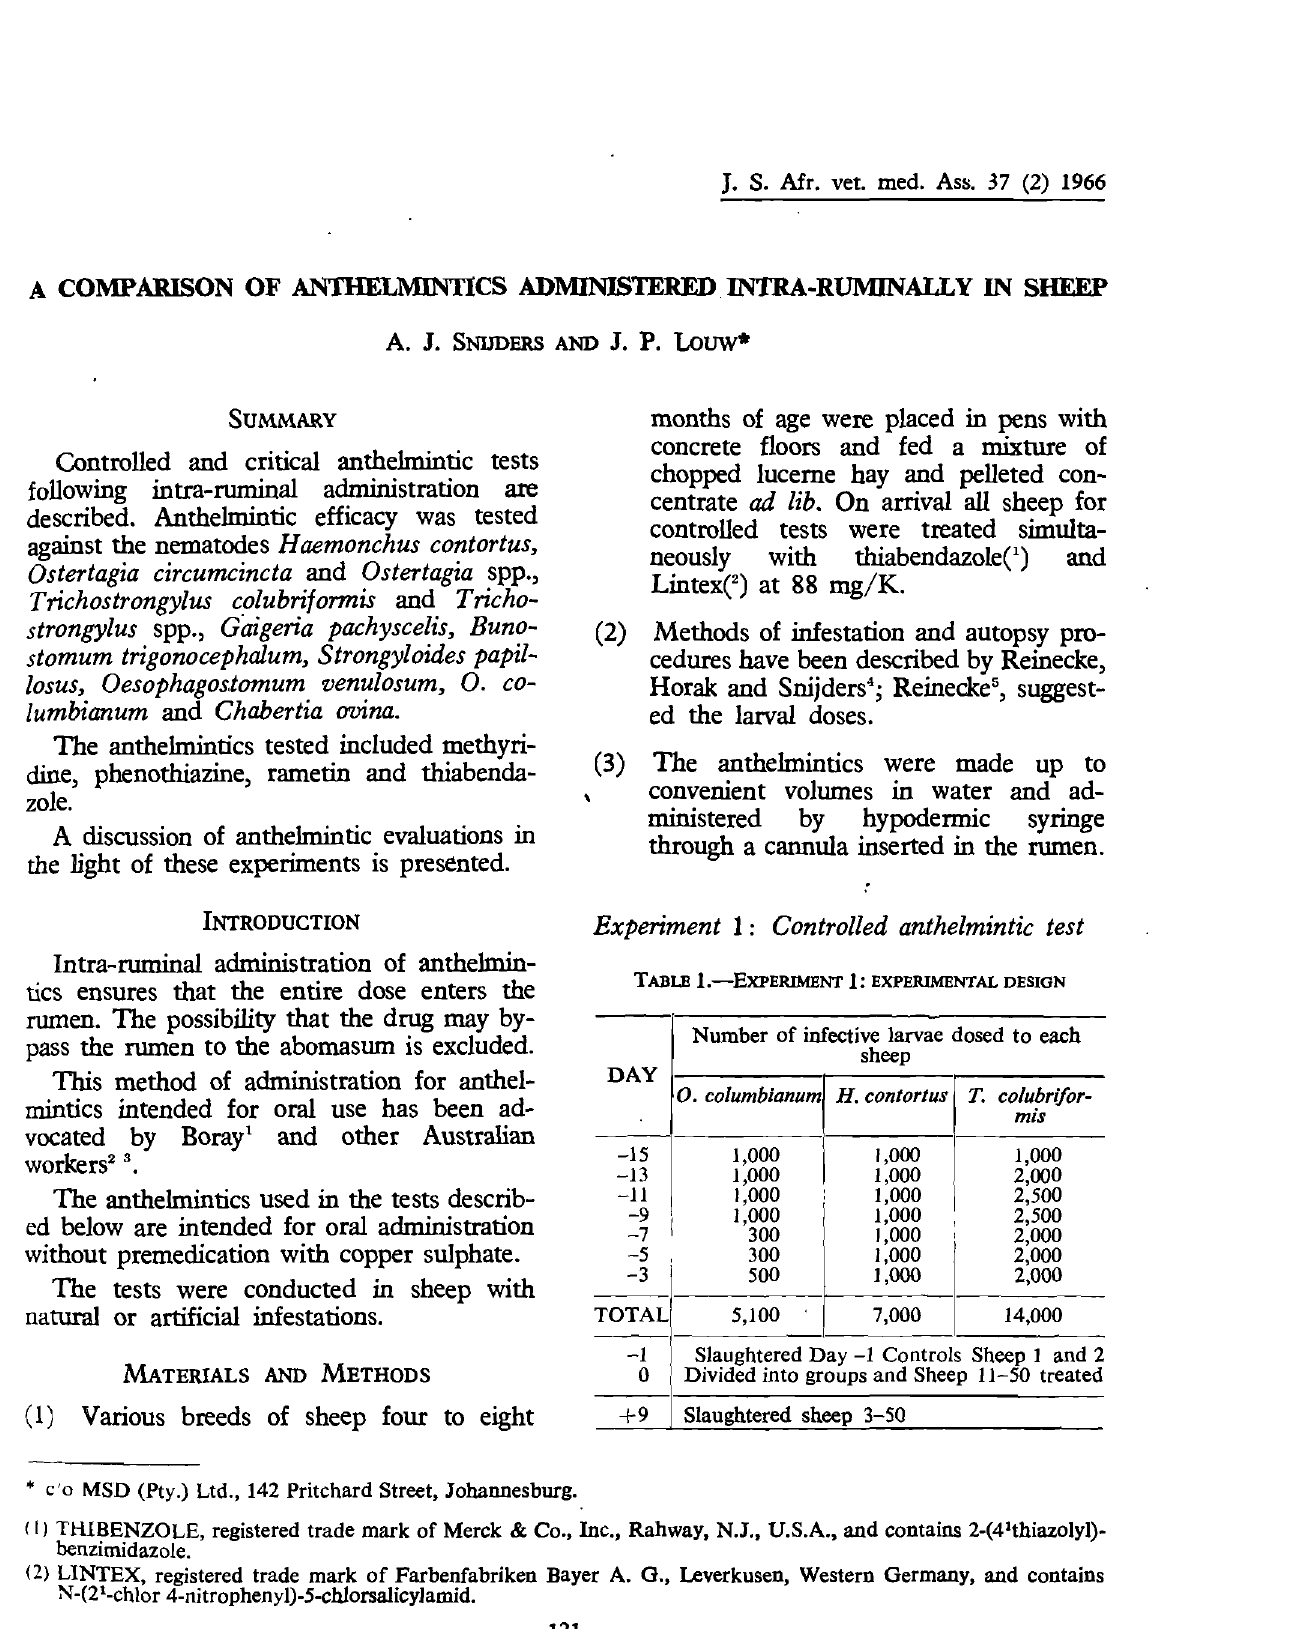
TABLE I.-EXPERIMENT 1: EXPERIMENTAL